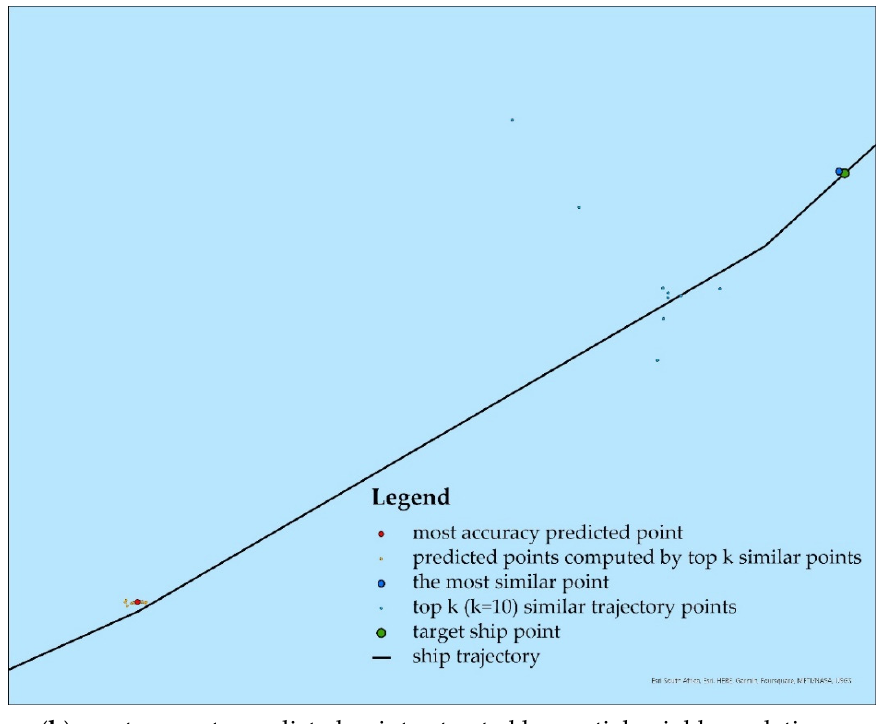
Figure 5. Examples of results obtained by the KNN model.